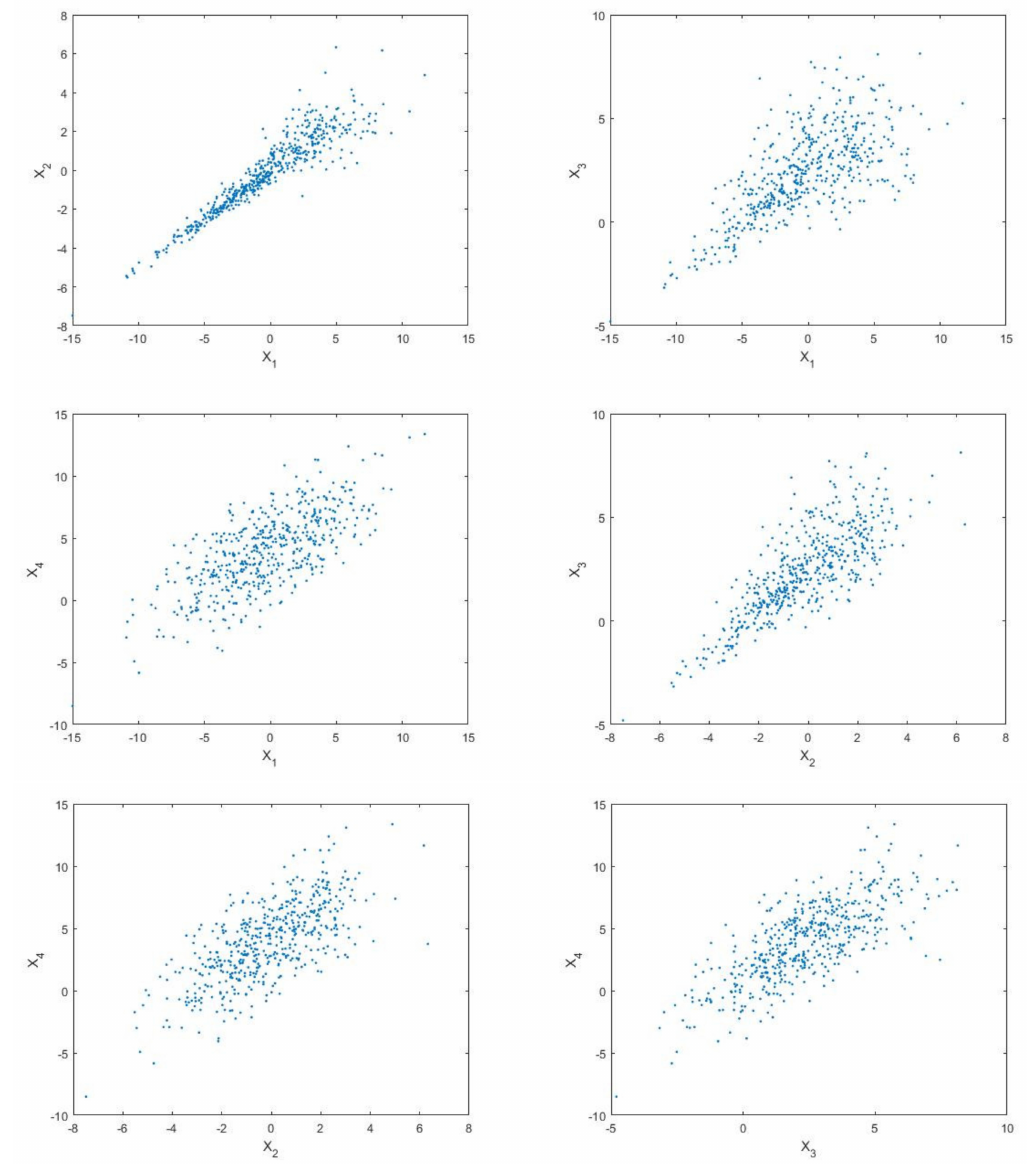
Figure 5. Sample distribution of input variables ( N = 500).